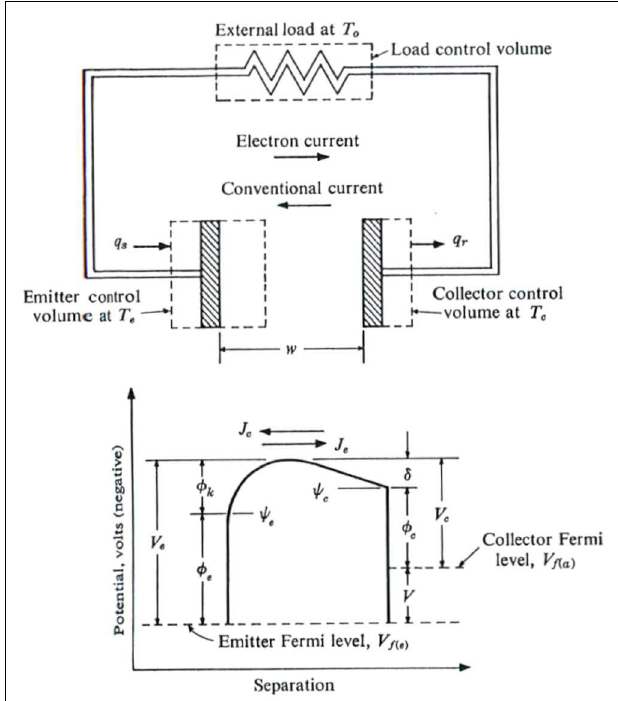
FIGURE 8 |A simple thermionic energy converter schematic (top) and electron potential (bottom) . Reprinted with permission from Angrist (1976).